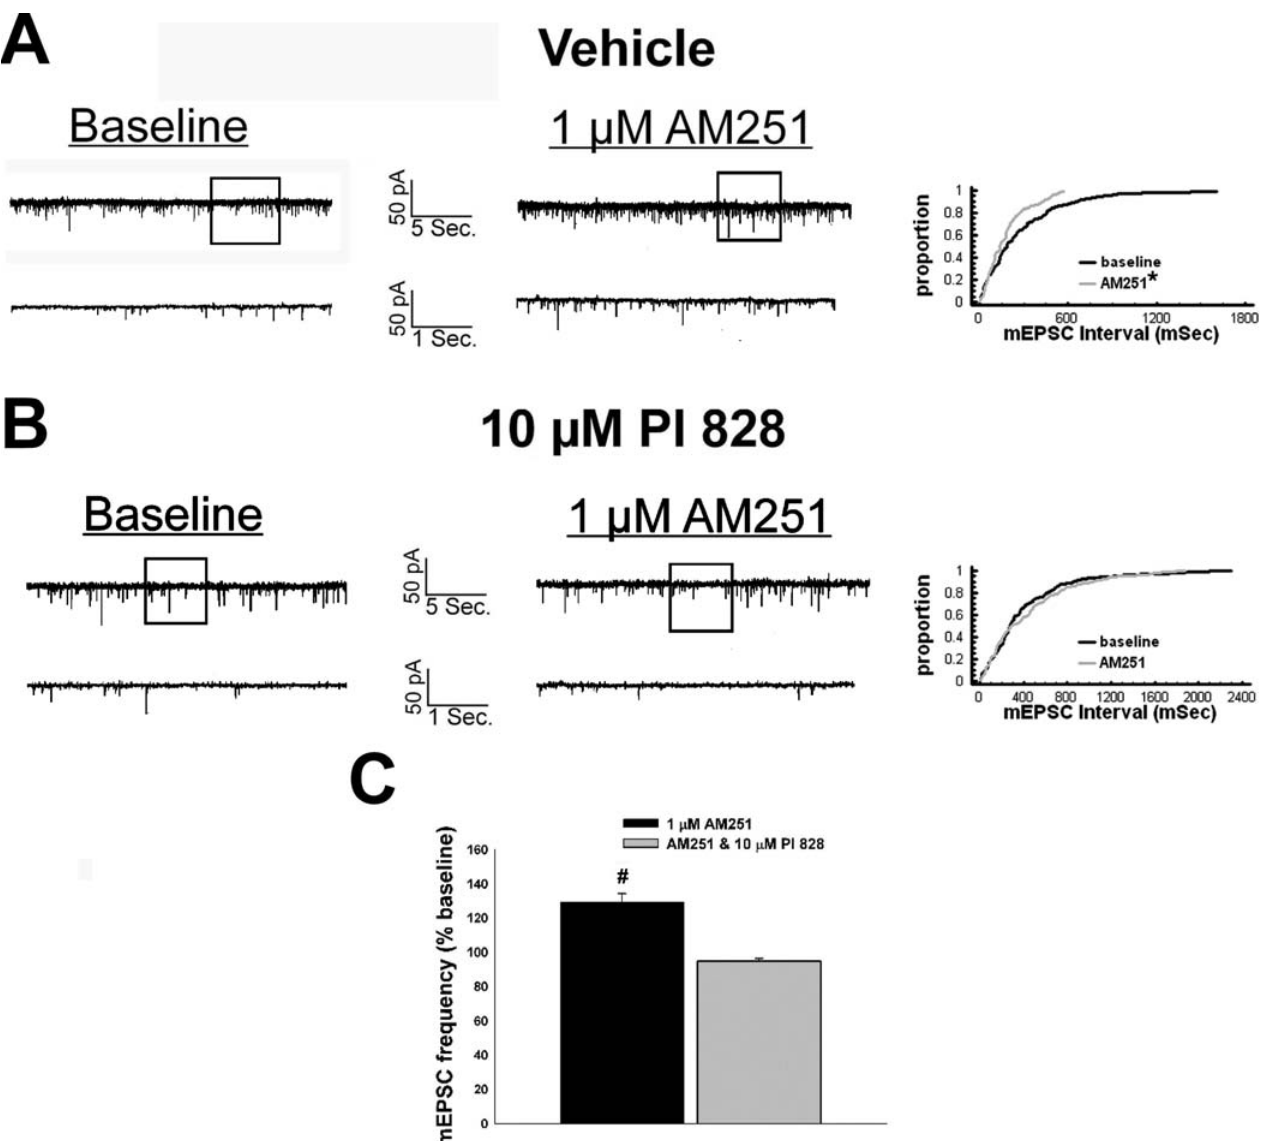
Figure 8. PI3K inhibition with PI 828 prevents the AM251-induced increase in glutamatergic input onto POMC neurons.